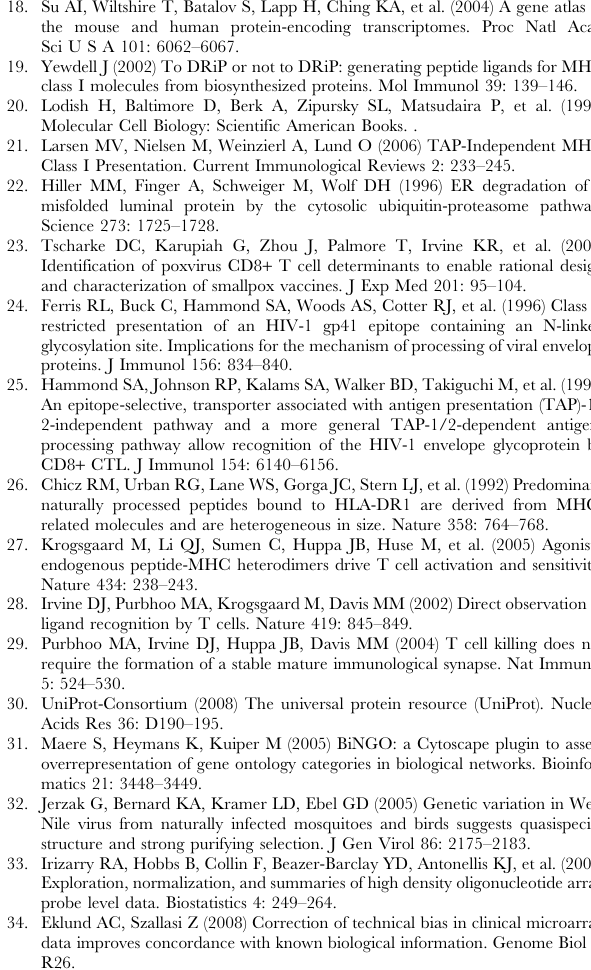
Table S3 mRNA expression levels of individual proteins. mRNA expression levels are taken from the GNF gene expression database. UniProtKB Acc: UniProtKB ACC number for the protein. Affy ID: Affymetrix ID for probes mapping to the protein. Expression value: Median expression value of all probes mapping to the protein. MHCI: A ‘‘1’’ in this column indicates that this protein is known to contain an MHC class I ligand, while ‘‘0’’ indicates that this protein is not known to contain an MHC class I ligand. MHCII: A ‘‘1’’ in this column indicates that this protein is known to contain an MHC class II ligand, while ‘‘0’’ indicates that this protein is not known to contain an MHC class II ligand. Found at: doi:10.1371/journal.pone.0007448.s005 (1.54 MB MVL NW MN SB OL. Wrote the paper: ASJ MVL